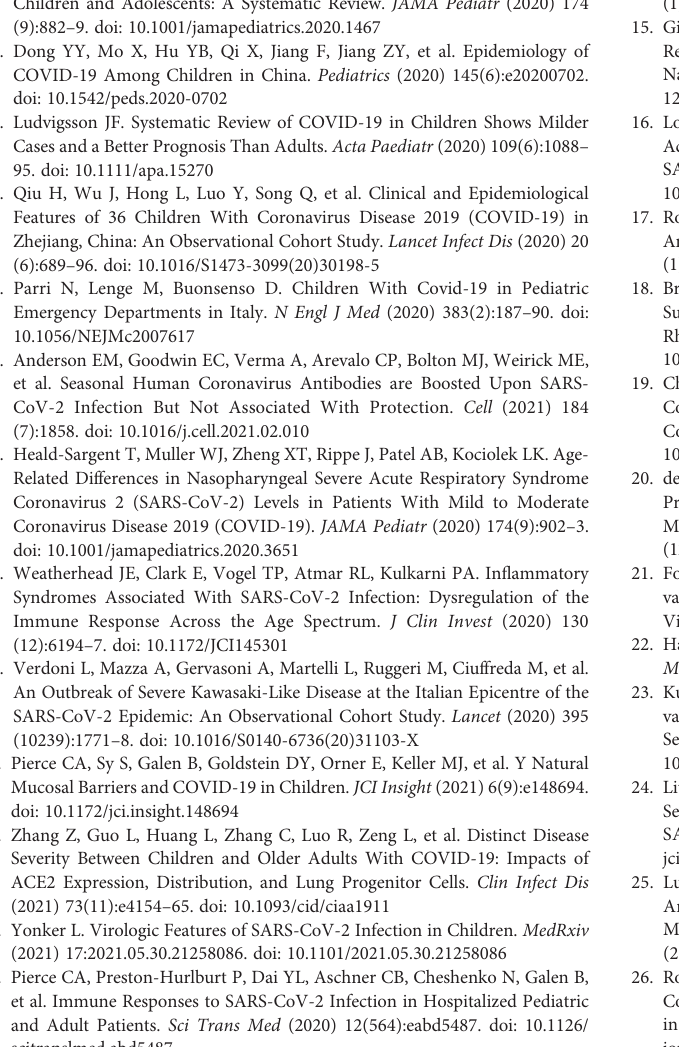
Supplementary Figure 6 | Cytokine analyses in blood from infected adults. Heatmap representing the evolution of cytokines over-time in three adults (in log of fold-change from the baseline). Variations are shown on a blue scale. Basal concentrations (pg/ml)areshownontheleftsideofthe heatmap.Highlightedyellow values correspond to the detection